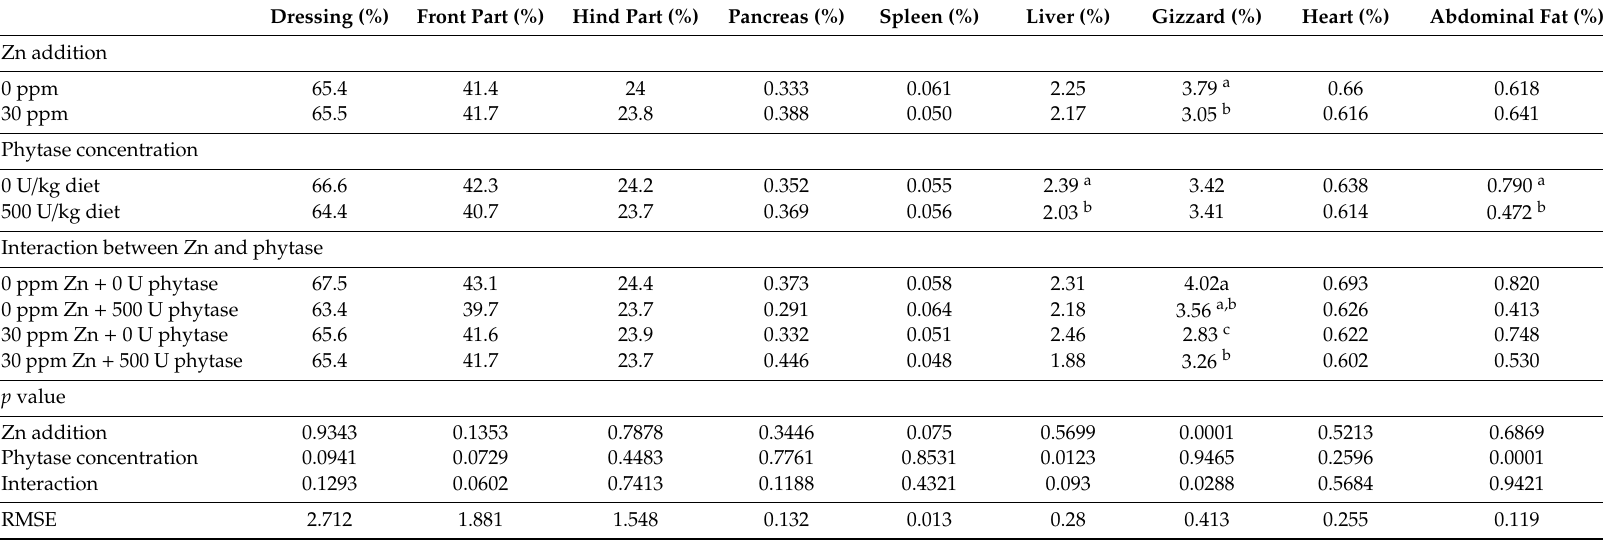
Table 4. E ff ect of zinc supplementation, with and without phytase addition, on the percentage weights of the dressed carcass, carcass parts, inner organs, and abdominal fat in White Pekin ducks